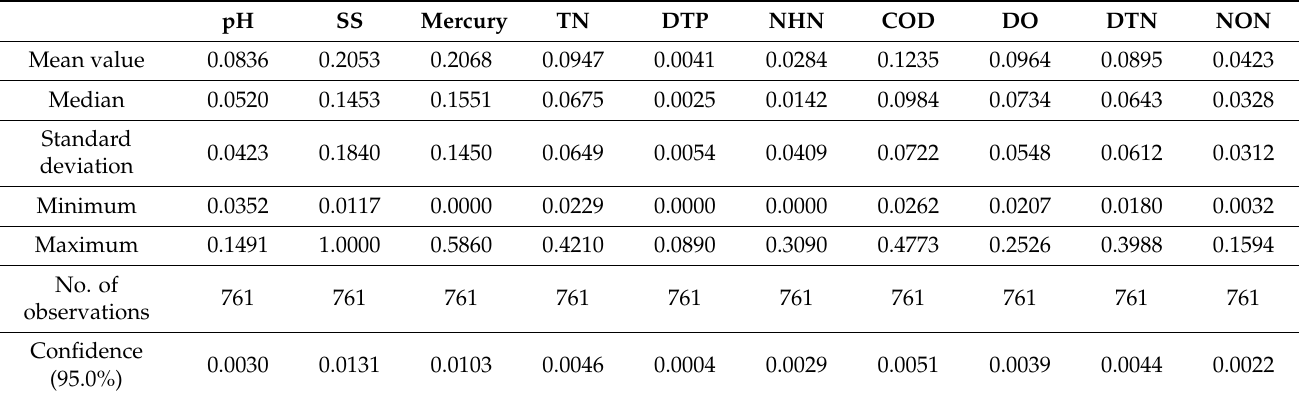
Table 4. Statistics of the